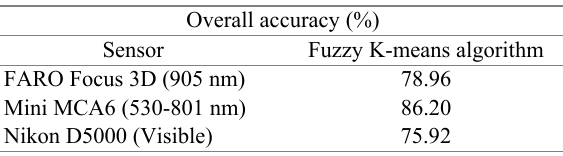
Table 1. Unsupervised classification accuracies achieved for each data